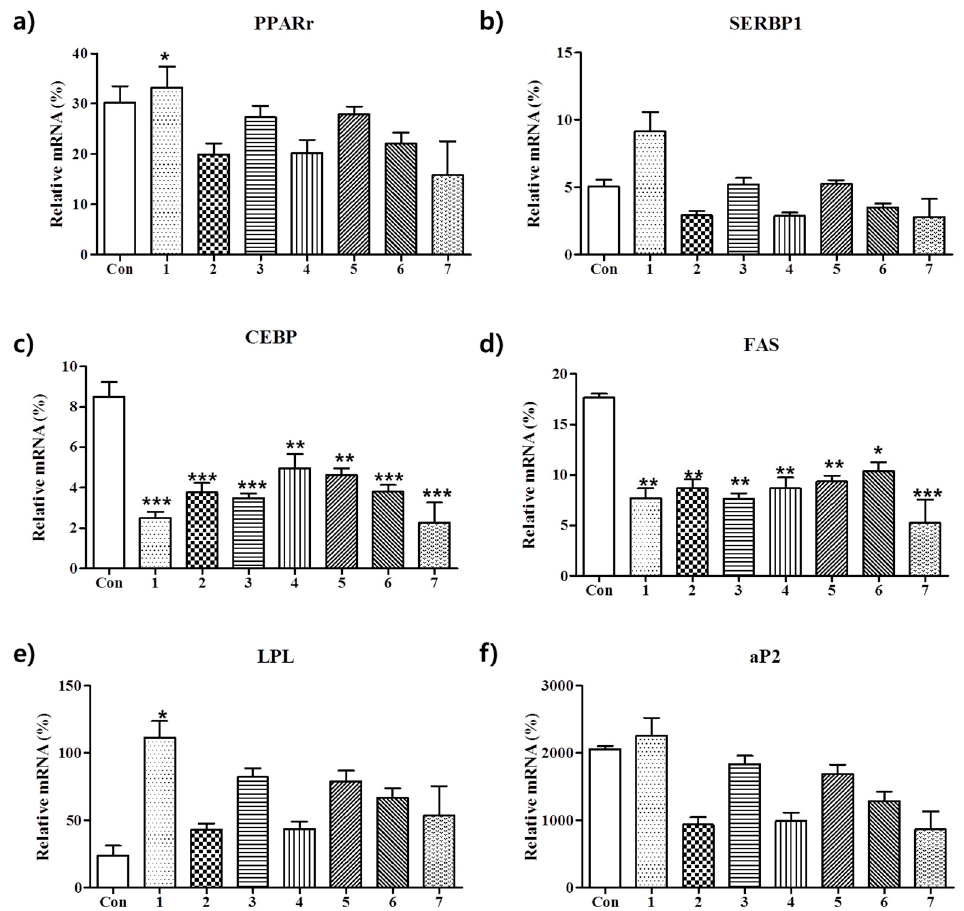
Figure 3. Inhibitions of the mRNA expressions of PPAR γ ( a ), SREBP1 ( b ), C/EBP α ( c ), FAS ( d ), LPL ( e ), and aP2 ( f ) by compounds 1 – 7 in differentiated 3T3-L1 cells. Cells were exposed to differentiation cocktail (0.5 mM IBMX, 10 µ g/mL insulin, and 1 µ M dexamethasone) in the presence or absence compounds 1 – 7 at a concentration of 10 µ M for eight days. Results are expressed as means ± SDs, n = 3 per group. * p < 0.05, ** p < 0.01, and *** p < 0.001 versus treatment naïve